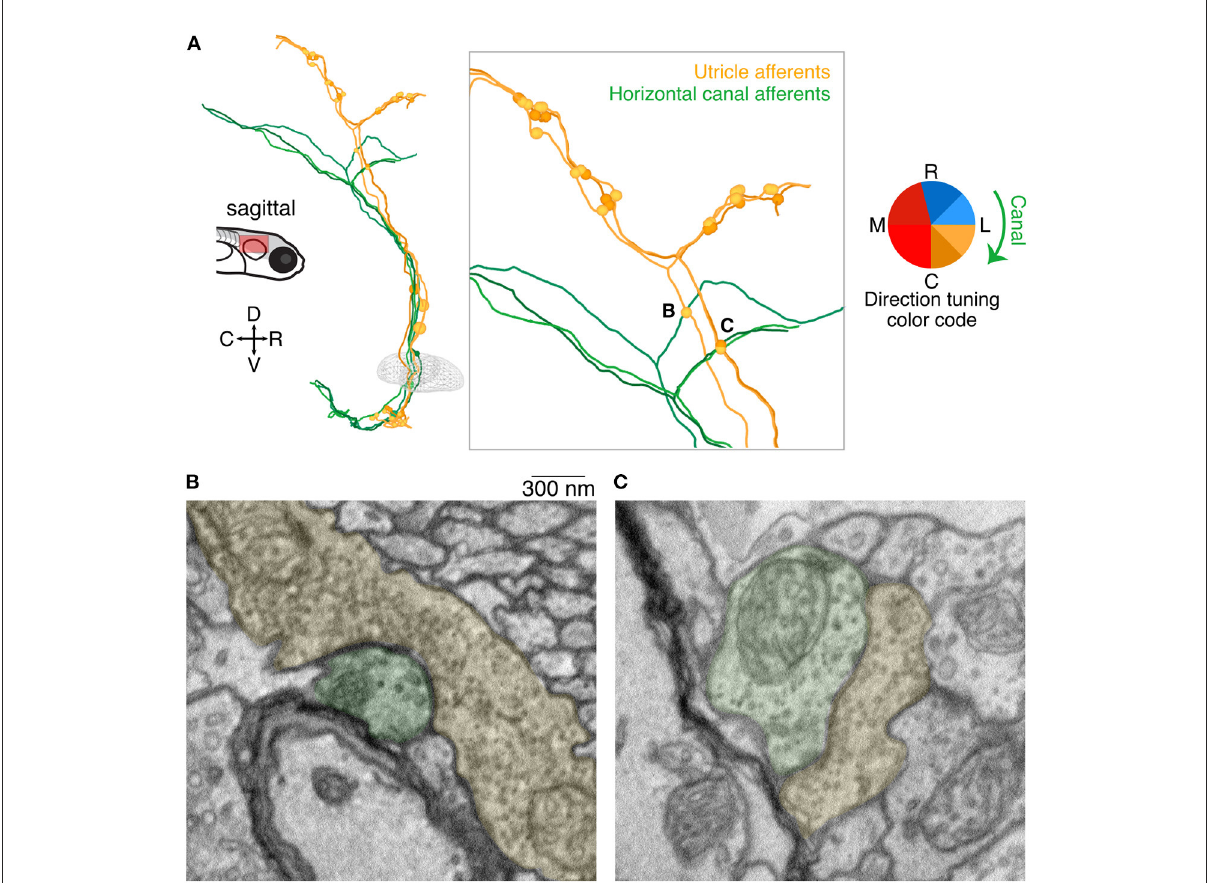
FIGURE6 Axo-axonic synaptic connections from utricular afferents to horizontal canal afferents. (A) Sagittal projection of reconstructions of three utricular afferents (yellows) and three horizontal canal afferents (greens). Each utricular afferent makes a synaptic connection onto one canal afferent, shown as small circles in the inset panel. Notably all of these apparent connections were found in the ascending branch of the utricular afferent before its central bifurcation, where no other synaptic connections were identified. Inset letters indicate the two synaptic connections shown in panels B and C. (B) Electron micrograph of one of the axo-axonic synapses shown in (A) . The utricular afferent (pseudocolored yellow) appears to have multiple release sites onto the canal afferent (pseudocolored green). Scale bar applies to both B and C. (C) As in (B) , for a second connection. The postsynaptic density is less pronounced in this image, but nonetheless the clustered vesicles suggest a synaptic